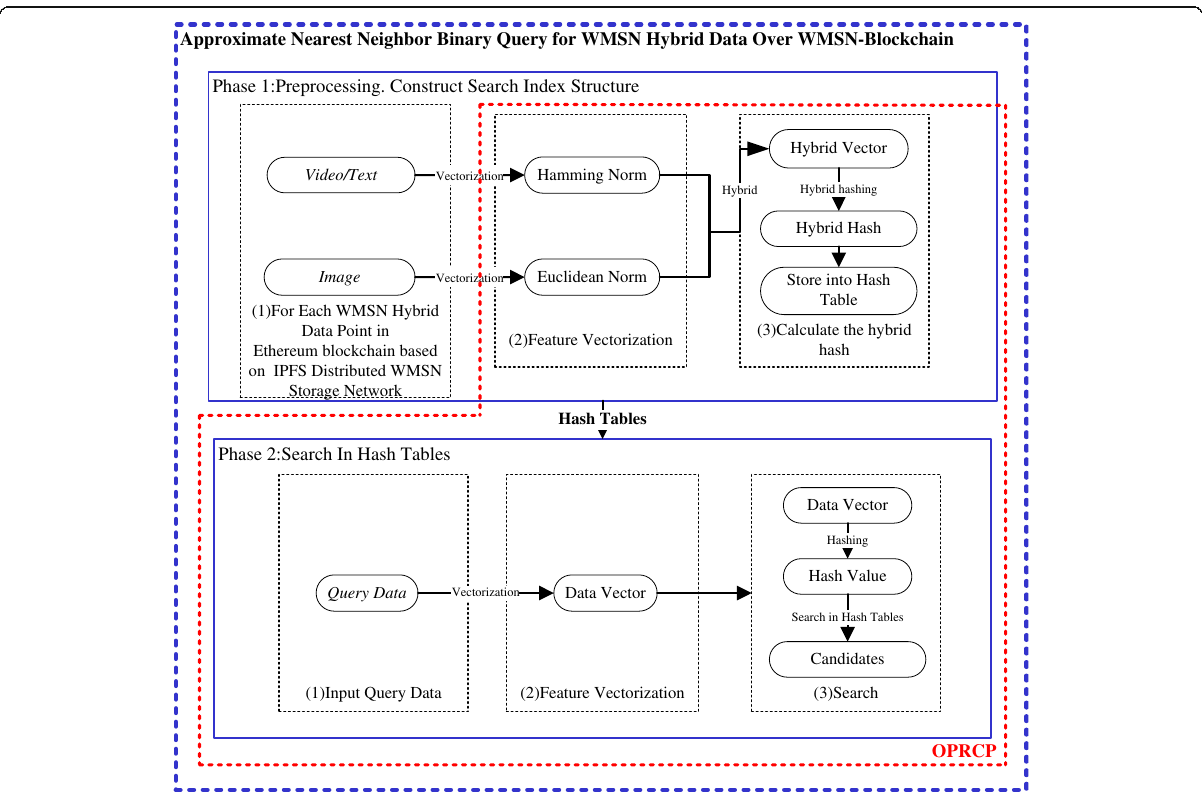
Fig. 1 The flowchart of approximate similarity binary search for WMSN hybrid data over Ethereum blockchain based on IPFS distributed WMSN storage